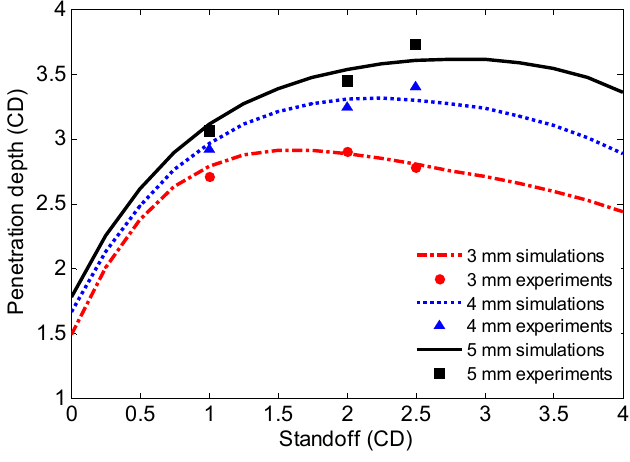
Figure 16. Initiation delay time affecting on penetration depth and optimum standoff.